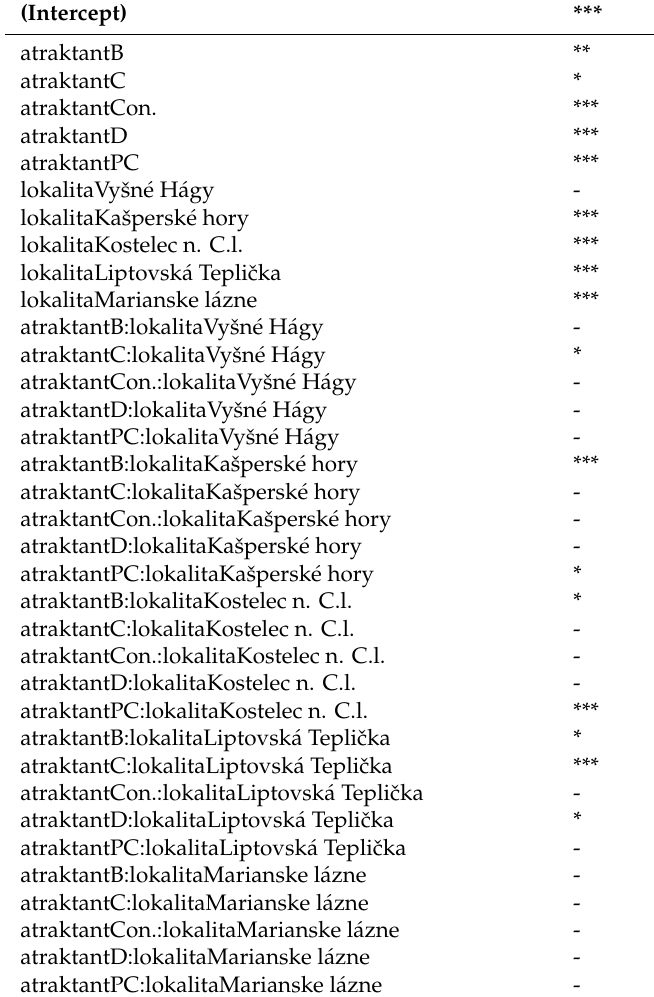
Table A2. Significant factors and their interaction.